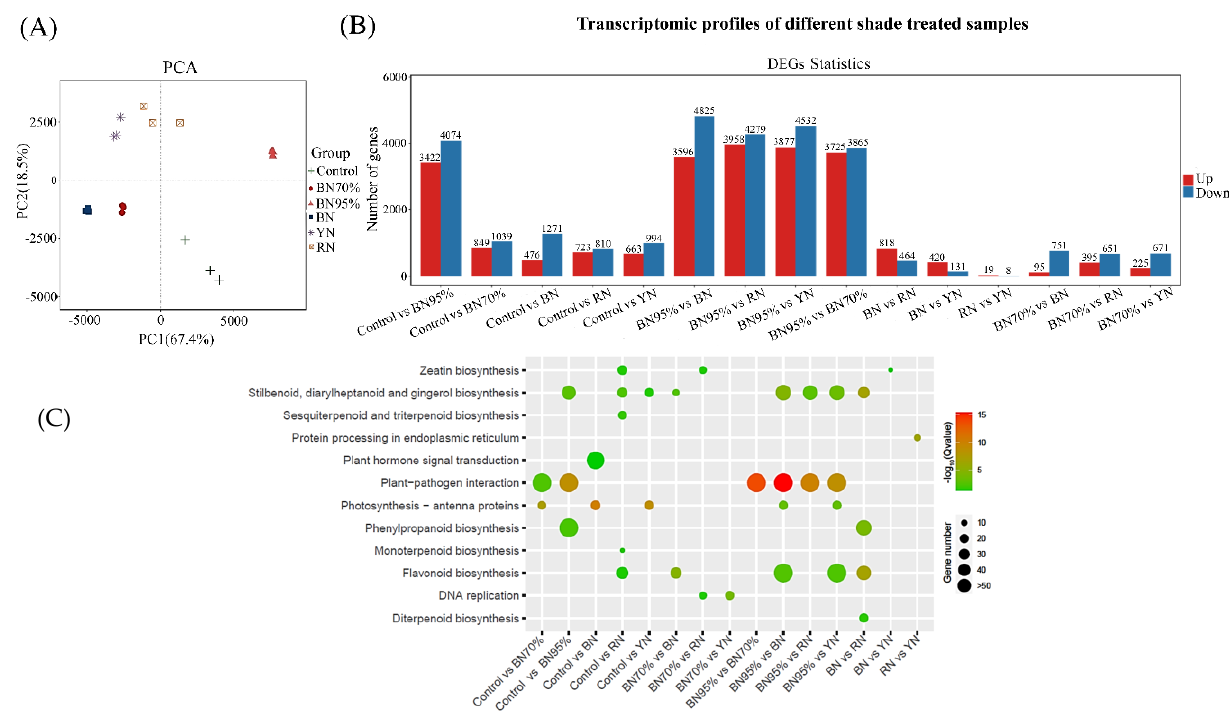
Figure 3. The gene expression profiles of the 2nd tea leaves. ( A ) PCA analysis; ( B ) DEG numbers; ( C ) significantly enriched KEGG pathways of DEGs for different shade treatments. The number of replicates is equal to 3.